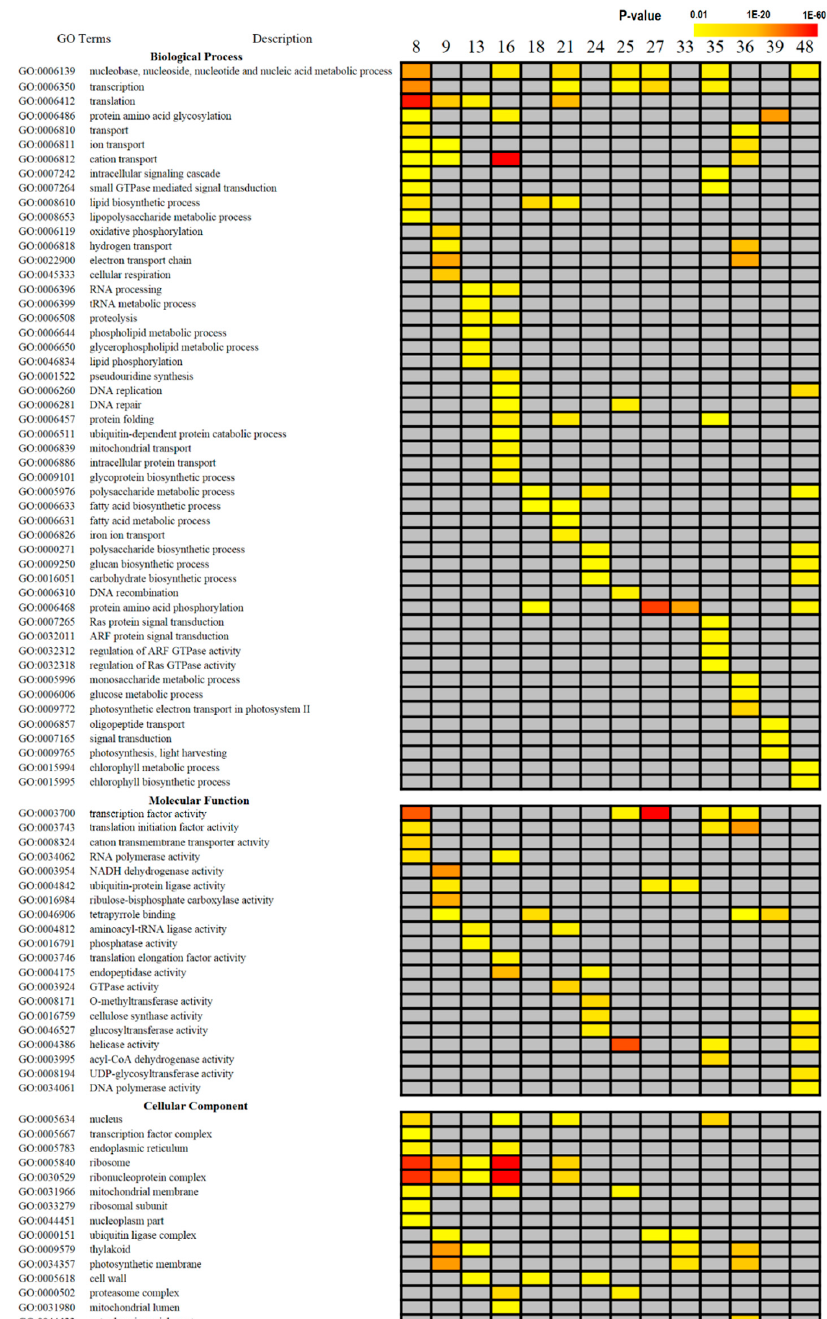
Figure 2. GO analysis of the differentially expressed genes in each cluster. Using p -value < 0.05 as the criterion, the overrepresented GO terms (biological process; cellular component; molecular function), in each cluster were selected using the agriGO analysis tool. The color depth is proportional to enrichment.